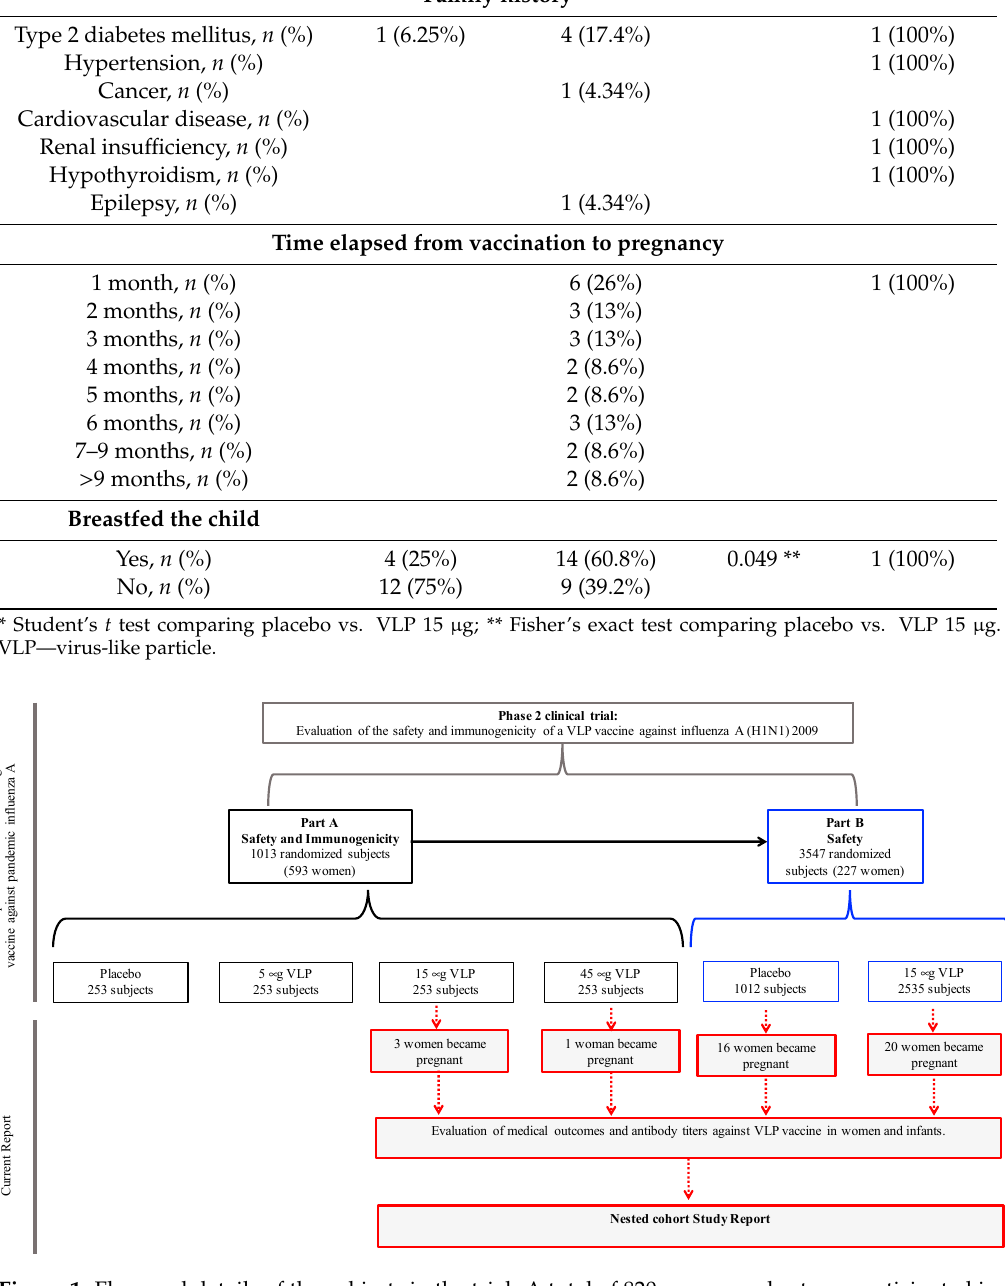
Figure 1. Flow and details of the subjects in the trial. A total of 820 women volunteers participated in the phase 2 clinical trial to evaluate the safety and immunogenicity (part A) and safety (part B) of the VLP vaccine against influenza A(H1N1)pdm09 [6]. After vaccination, 40 women became pregnant—16 from the placebo group, 23 from the 15 µ g VLP vaccine dose, and 1 from the 45 µ g VLP vaccine